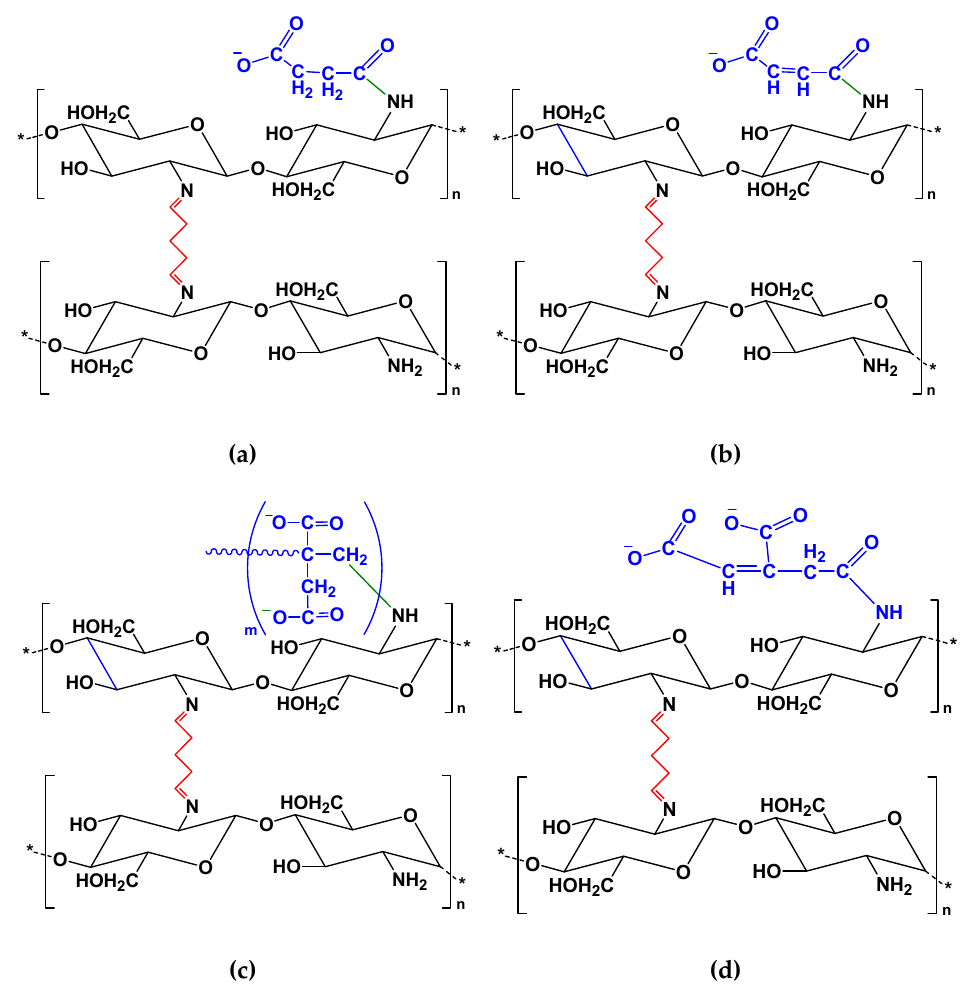
Figure 2. Chemical structure of the prepared chitosan grafted and cross-linked adsorbents: ( a ) CsSUC; ( b ) CsMAL; ( c ) CsITA; ( d ) CsTACON.